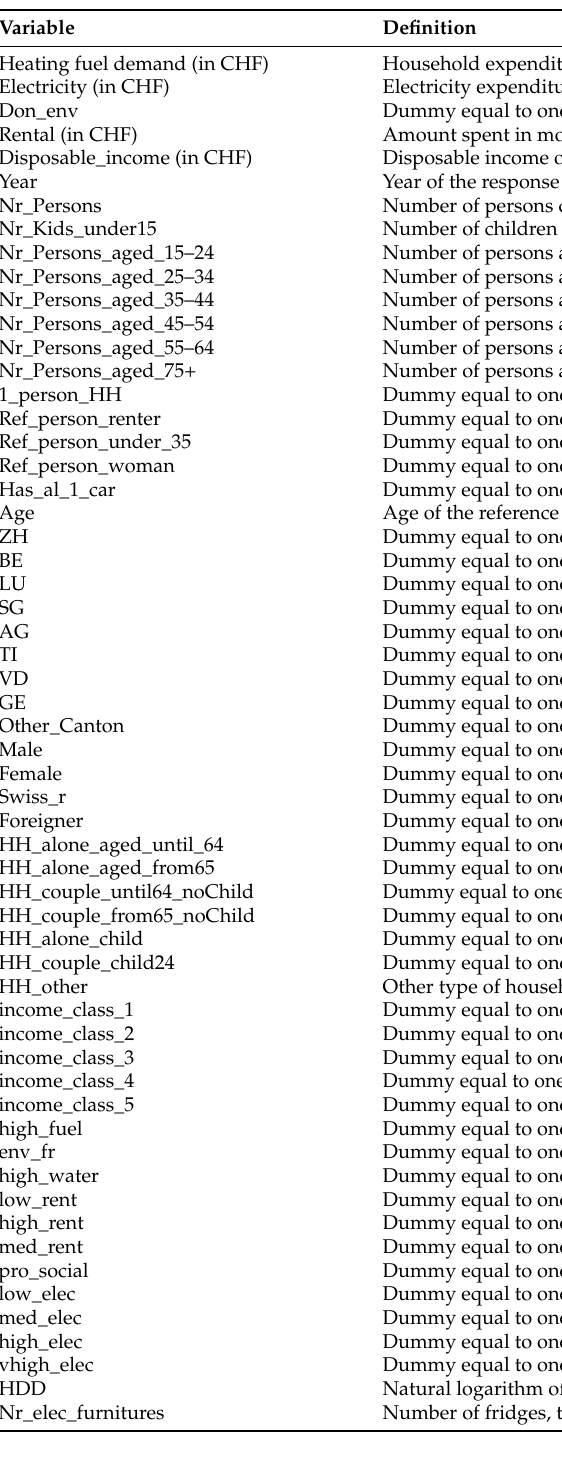
Table A1. Description of